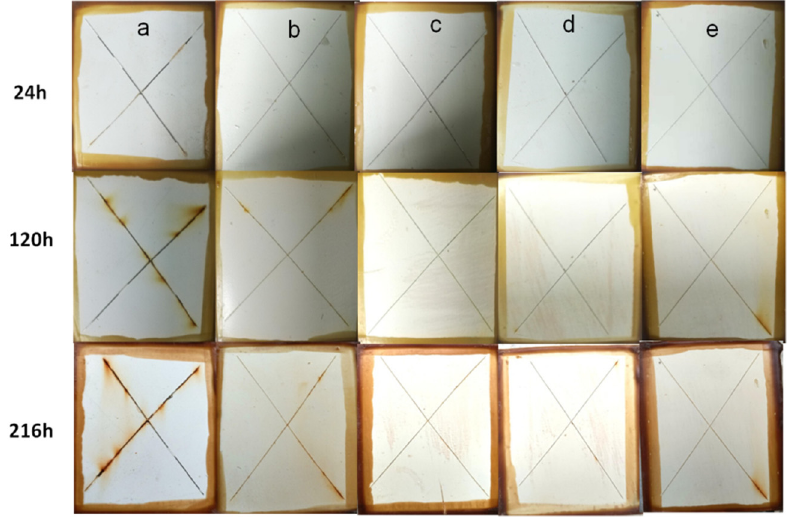
Figure 11: Salt spray test diagrams at di ff erent times: ( a ) AR - F, ( b ) 1% SiO 2 @AR - F, ( c ) 2% SiO 2 @AR - F, ( d ) 3% SiO 2 @AR - F, and ( e ) 4% SiO 2 @AR - F.